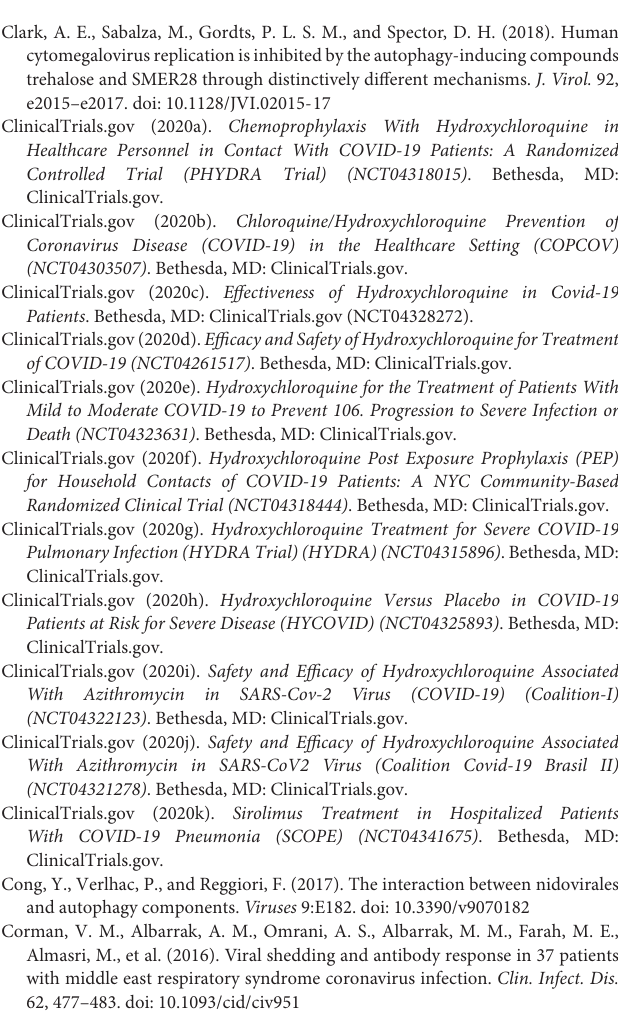
FIGURE S1 | Taxonomy of CoVs Classification scheme of some representative human (in red) and animal (in black) coronaviruses. Abbreviations: FCoV, feline coronavirus; TGEV, transmissible gastroenteritis virus; PRCV, porcine respiratory coronavirus; HCoV, human coronavirus; PEDV, porcine epidemic diarrhea